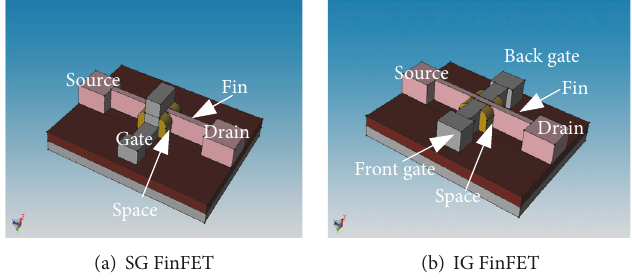
Figure 1: 3D structure of FinFET: (a) SG FinFET and (b) IG